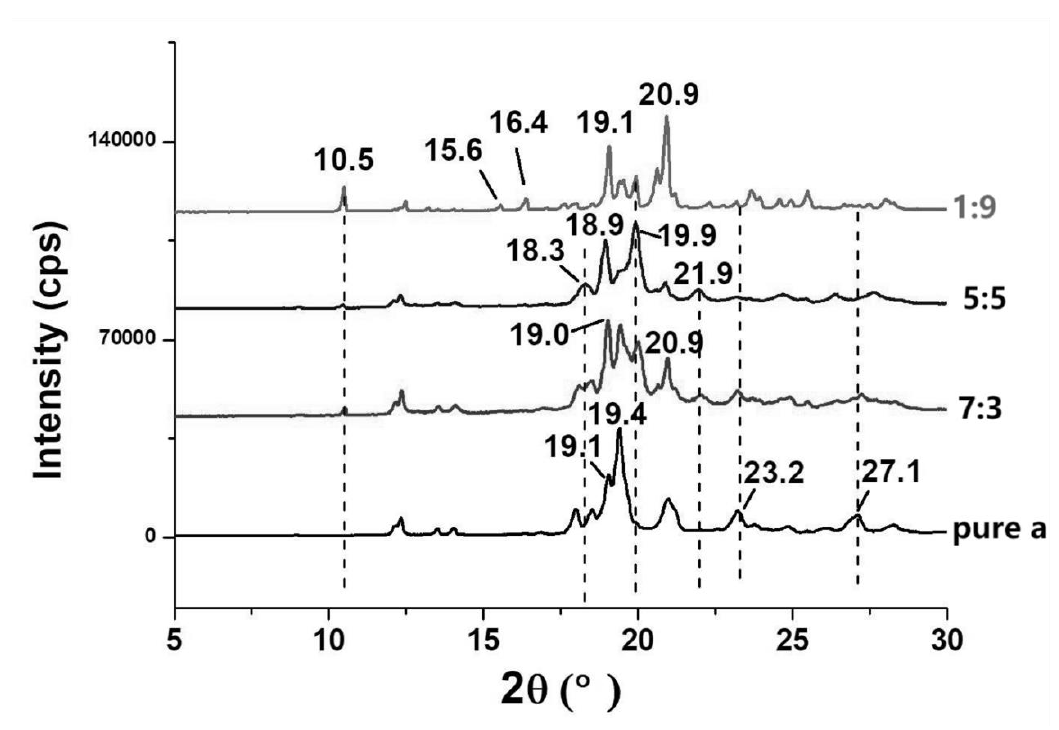
Figure 4. XRD patterns of the pollen-like anhydrous lactose with tailored α/ β ratios.